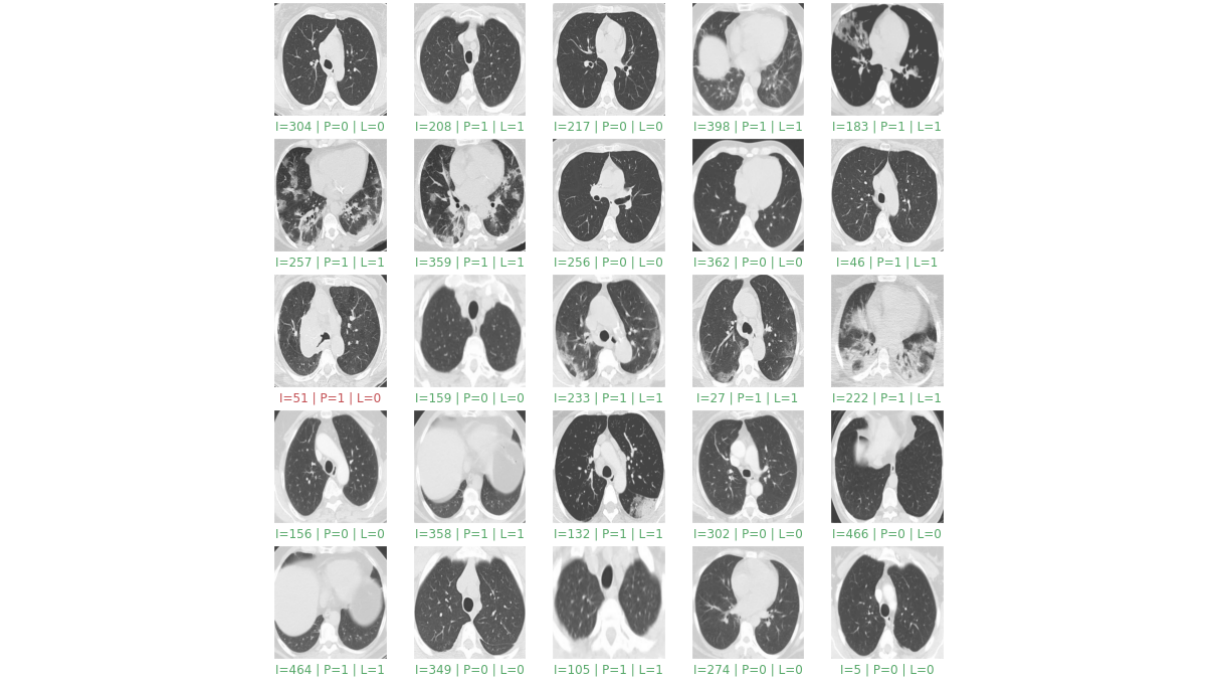
Figure 5. Results of detection on 25 random samples from the test set. “I” is the image index, “P” is the predicted value, and “L” is the grand truth label. Green indicates correct detection and red indicates incorrect